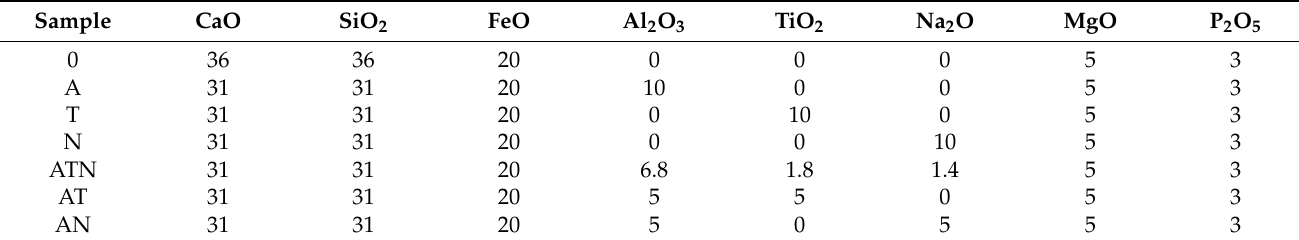
Table 1. Experimental materials (wt.%).